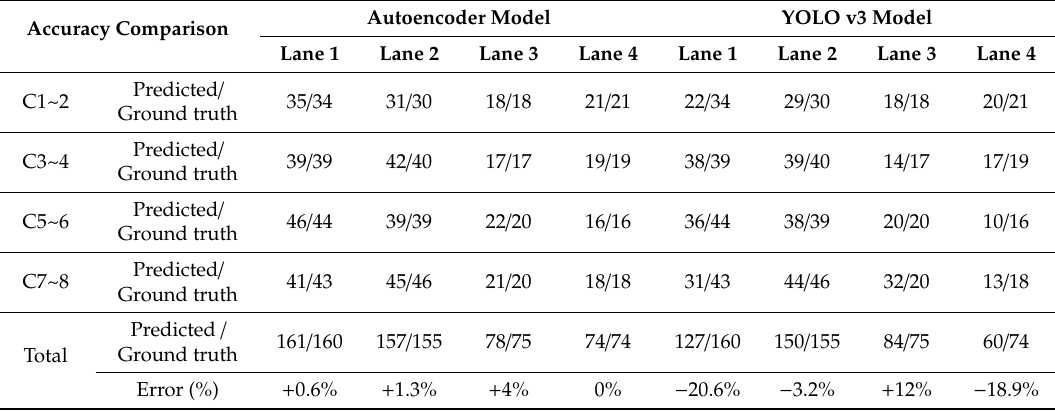
Table 2. Comparing the accuracy of the proposed model with that of the reference